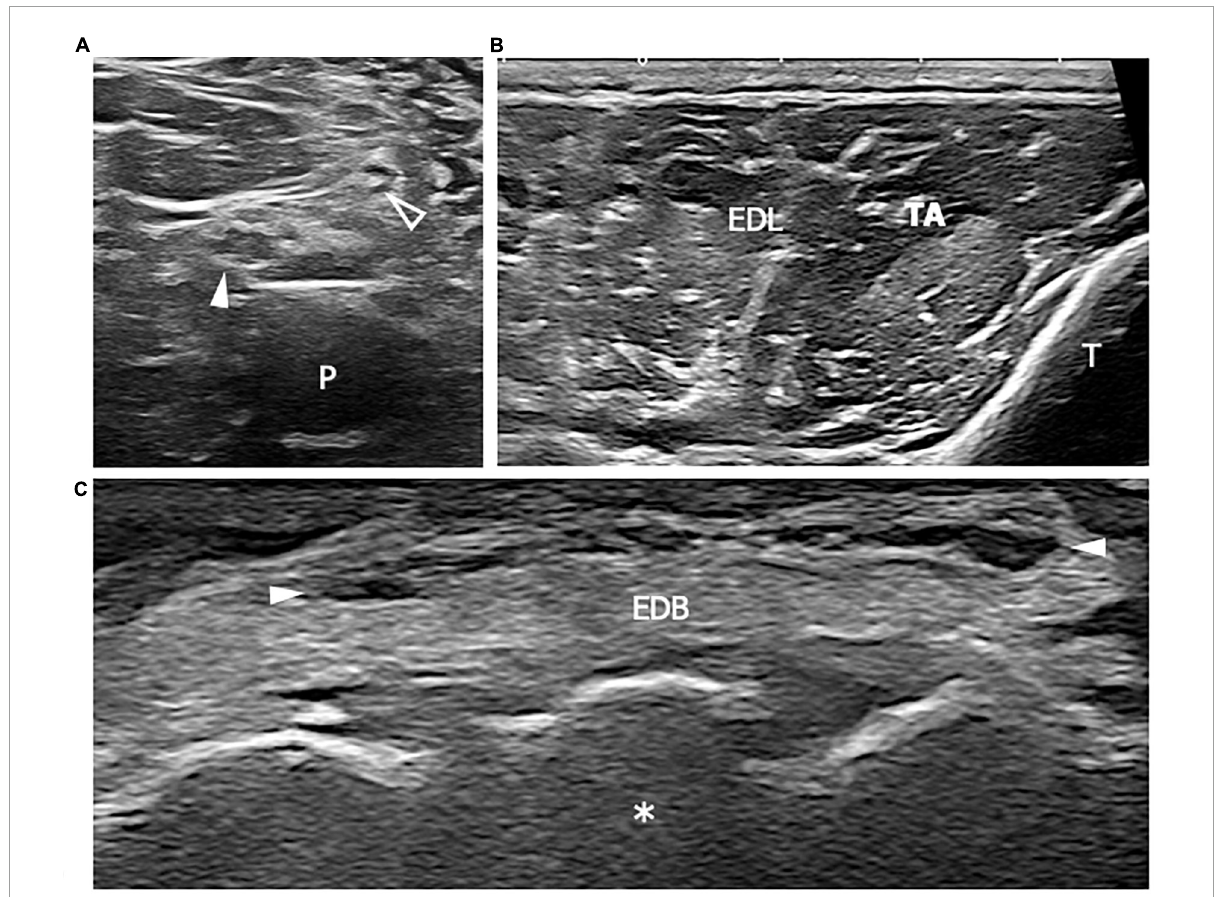
FIGURE1 This figure shows three 18 MHz HRUS images (A–C) of a 44 years old male affected by a mixed connective tissue disease with a lower limb sensory-motor axonal neuropathy. As frequently seen in the axonal neuropathies, in (A) no significant morphological changes of the tibial (white arrowhead) and fibular (empty arrowhead) nerves in the popliteal fossa are seen. At the proximal third of the leg, the axial scan in (B) does not reveal any sign of denervation in the anterior compartment of the leg muscles (tibialis anterior, TA and extensor digitorum longus, EDL). However, the extensor digitorum brevis muscle (EDM) in (C) exhibits signs of advanced atrophy with fat replacement of the muscle fibers. The isolated atrophy of EDM has been described as being associated with axonal neuropathies of different etiologies and it could represent the only HRUS finding under these conditions. White arrowheads in (C) represents EDL tendons. P, popliteal vein; T, tibia; white asterisk, tarsal